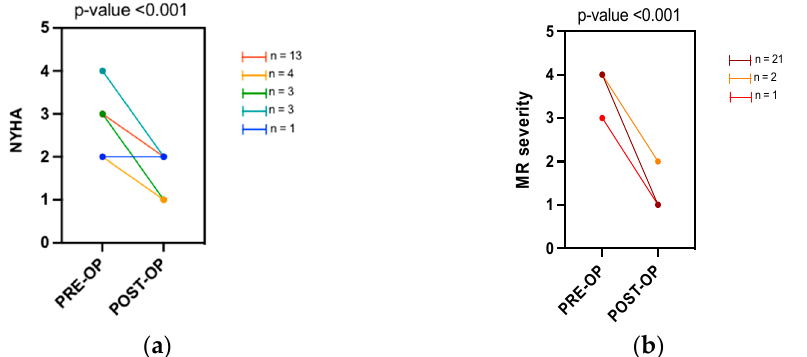
Figure 1. Change in NYHA class ( a ) and in mitral regurgitation severity ( b ) pre- and post-TEER. Legend: NYHA, New York Heart Association classification; pre-op, baseline evaluation; post-op, follow-up evaluation; MR mitral regurgitation.